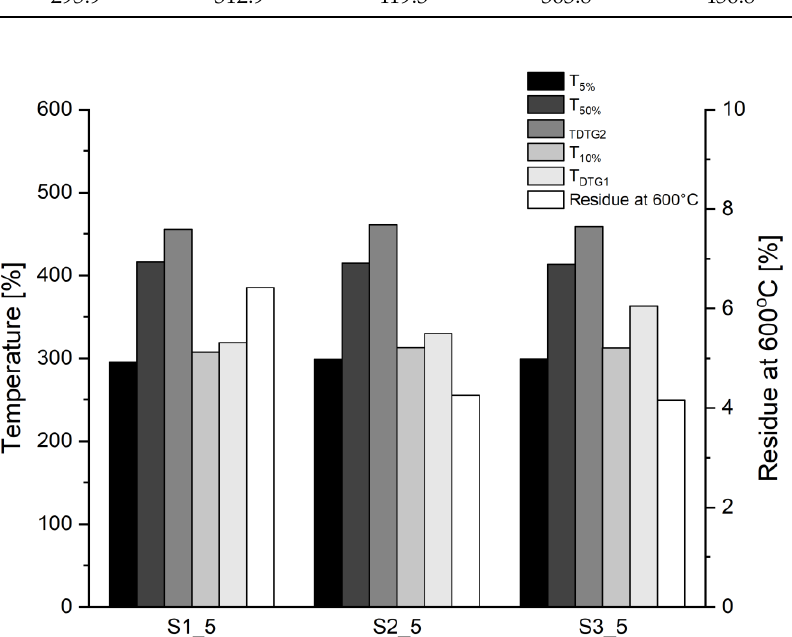
Figure 5. Comparison of T 5% , T 10% , T 50% , T DTG1 , T DTG2 , and residue at 600 ◦ C for bio-TPU–ABW composites containing 5 wt.% of the ABW fillers.